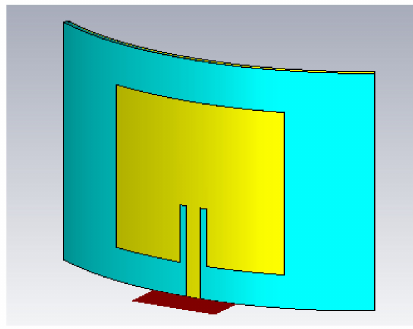
Figure 5. Patch antenna with a flexible